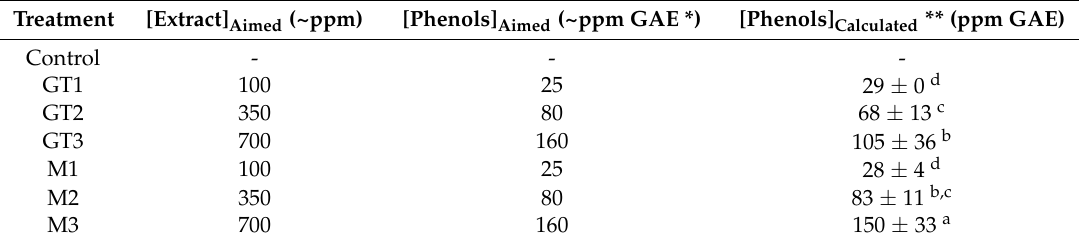
Table 1. Concentration of extract (aimed) and phenols (aimed and calculated, mean ± sd) in brine injected-pork chops.